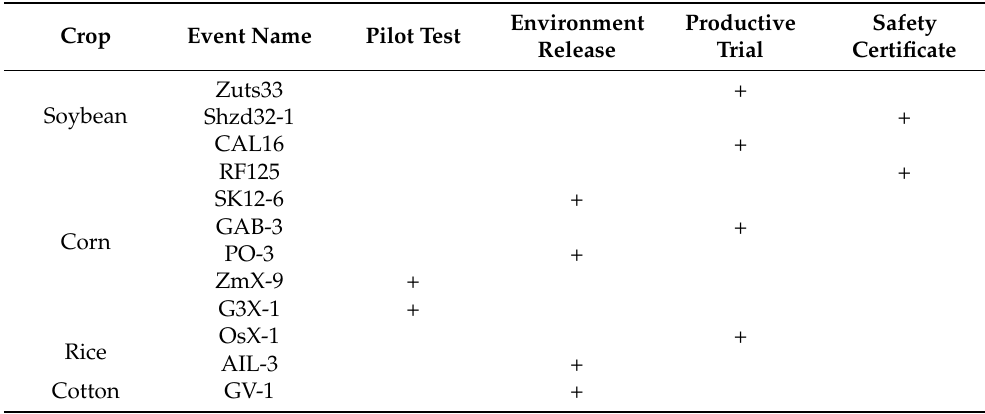
Environment Productive Safety Release Trial Certificate